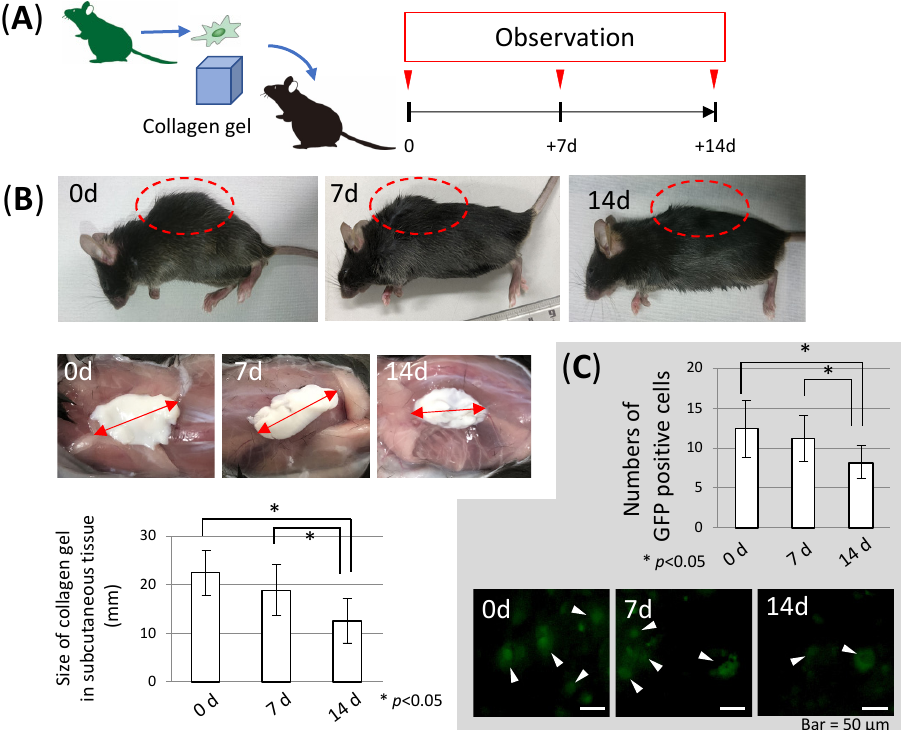
Figure 2. MSC stability in a subcutaneously implanted collagen scaffold. ( A ) Experimental protocol for in vivo experiments. ( B ) (Upper) Appearances of mice backs after collagen injection (immediately, 7 days, and 14 days after injection). (Lower) Shapes of collagen gels in the backs of mice (immediately, 7 days, and 14 days after injection). The size of the collagen gel decreased over time. ( C ) Numbers of green fluorescent protein (GFP) positive cells in collagen gels at time of injection and upon removal from mice backs at 2 weeks after injection (Number of cells per 500 × 500 µ m field in section). More than half the cells remained alive for 2 weeks. * p < 0.05.